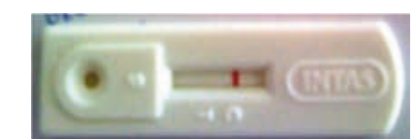
Fig.1. Positive result of rapid antigen detection kit ( Control and test bands are visible).